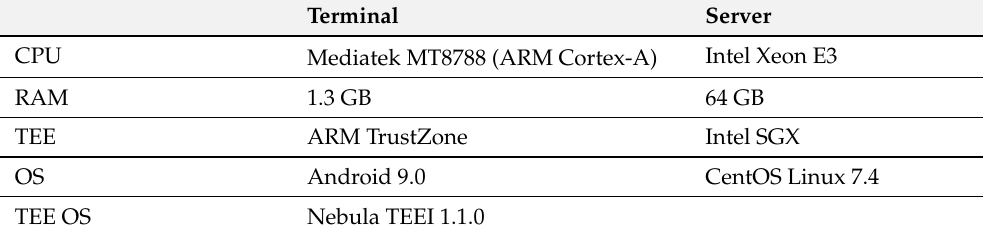
Table 3. The Configurations of Mobile Terminals and the